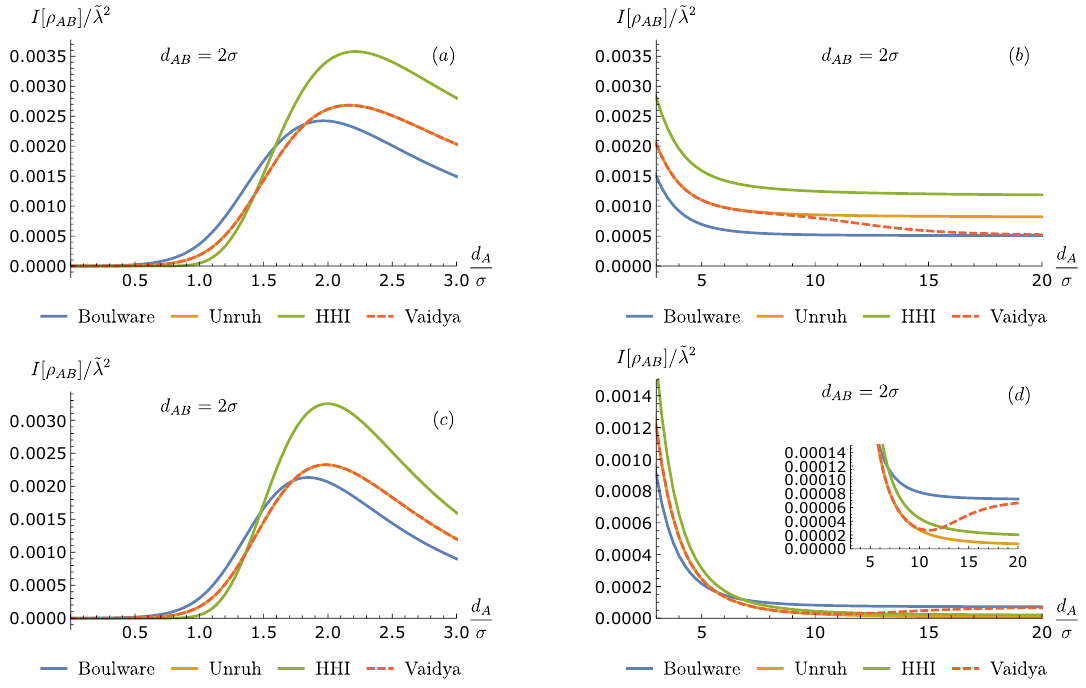
Figure 6 . Mutual information as a function of proper distance of detector A away from the horizon (in units of (cid:27) ) for various choice of vacua. Here ~ (cid:21) = (cid:21)(cid:27) 1 (cid:0) n 2 = (cid:21) is dimensionless coupling constant. We set (cid:10) (cid:27) = 2, M=(cid:27) = 1 . The detectors are turned on at (cid:28) 0 = 12 (cid:27) so that the Gaussian switching 2 peak is very far from the shell. (a) the nonlocal term M . (a) and (b): d ( r A ; r B ) = 2 (cid:27) . (c) and (d): d ( r A ; r B ) = 3 (cid:27)